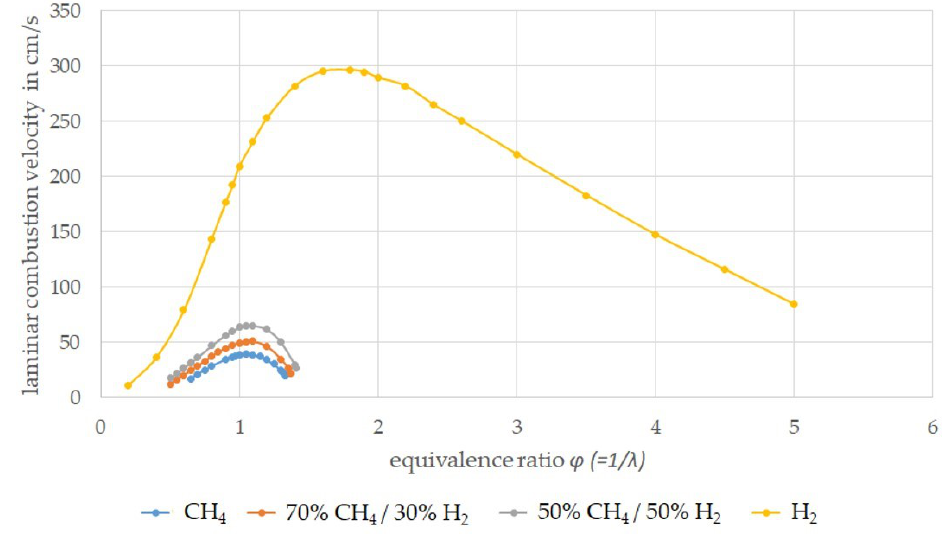
Figure 4. Laminar combustion velocity of CH 4 , CH 4 /H 2 blends and H 2 as a function of the equiva- lence ratio (=1/ λ